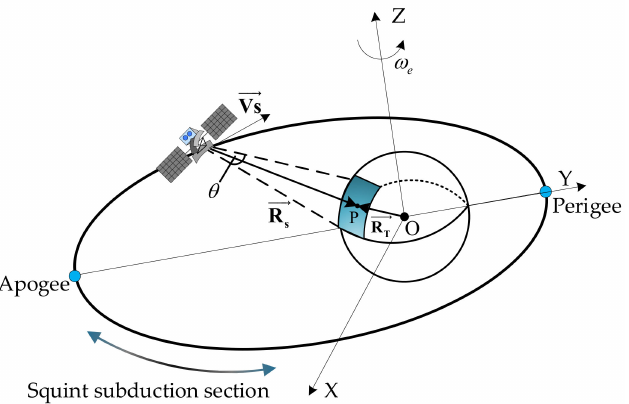
Figure 2. Geometric configuration of HEO